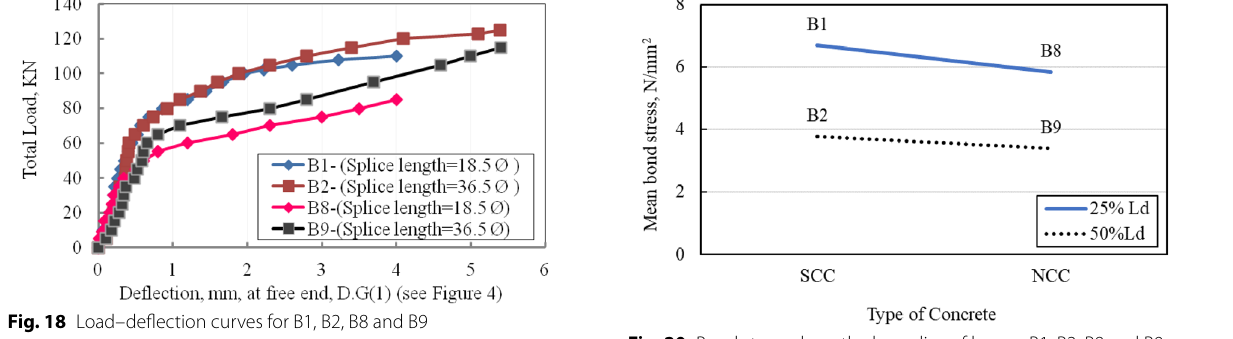
Fig. 20 Bond stress along the lap splice of beams B1, B2, B8 and